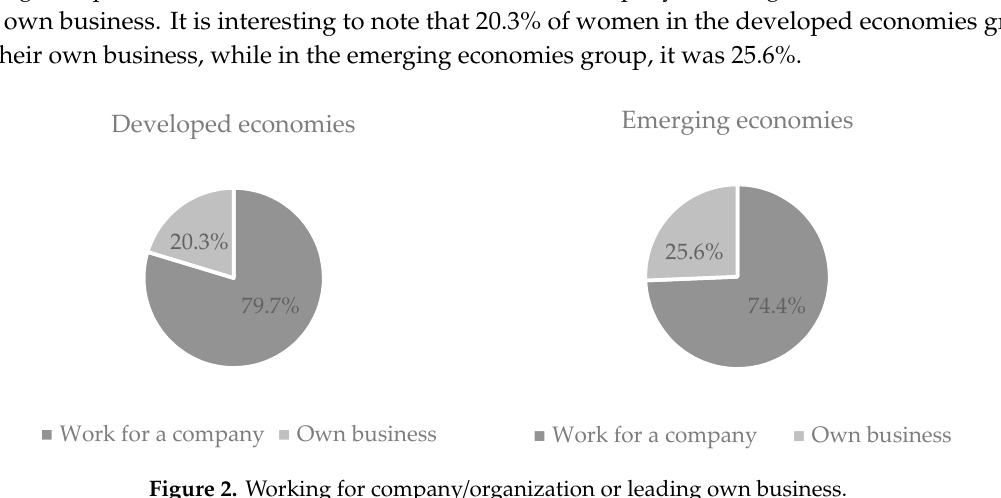
Figure 2. Working for company/organization or leading own business.